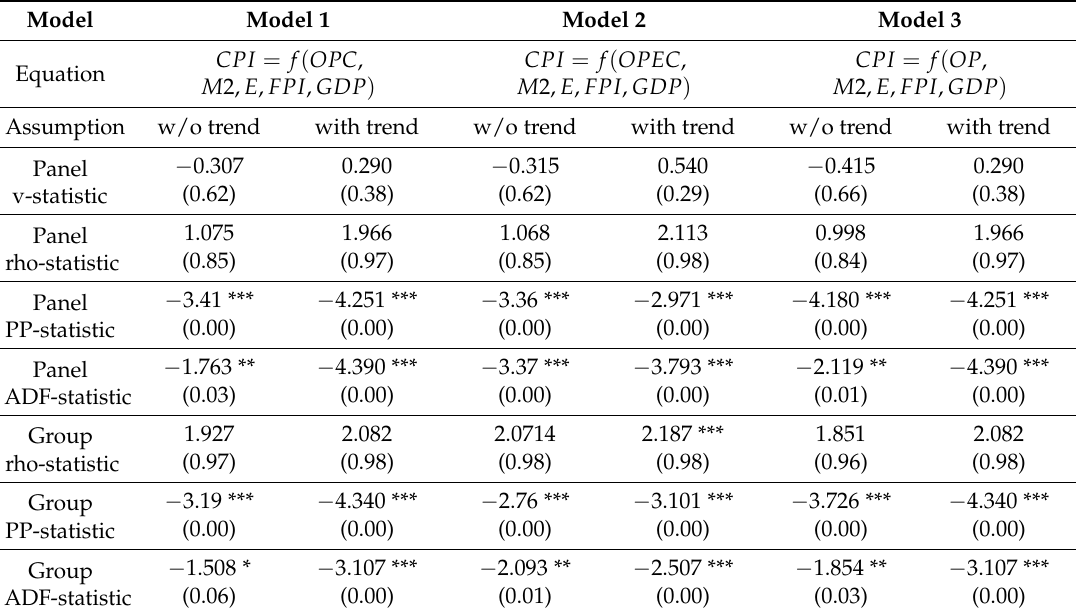
Table A2. Linear panel cointegration results.